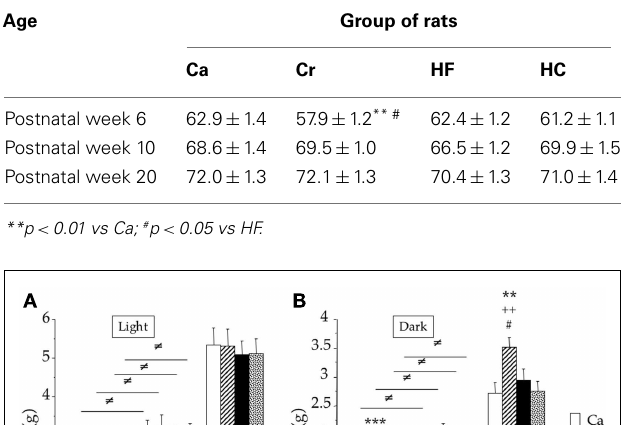
Table 3 | Subcutaneous, perirenal, and epididymal fat depot weights (mean ± SEM in grams) in offspring from dams fed either a gestational control diet (Ca group) ad libitum , or a restricted control (Cr group), a high-fat (HF group), or a high-carbohydrate (HC group) diet ad libitum for 6h during the light period, in addition to two normal meals given during the dark period.